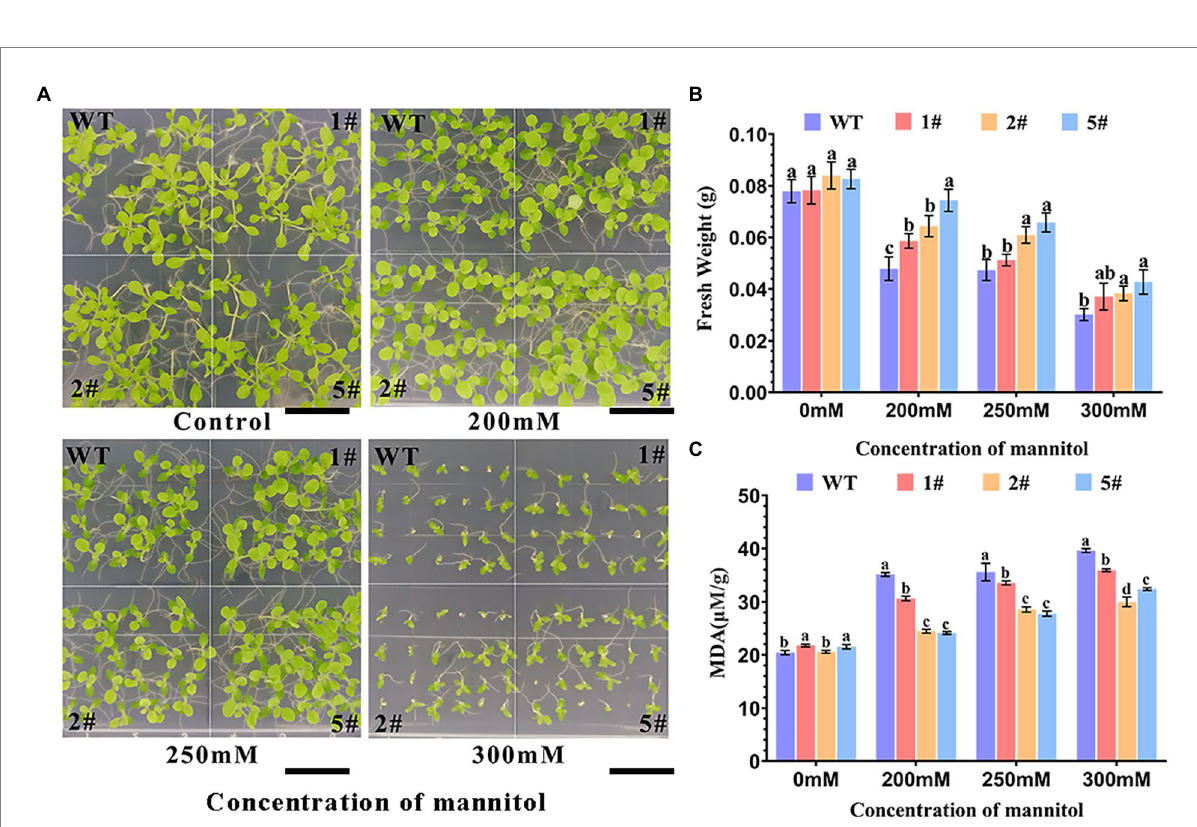
FIGURE 5 Plant root growth of an AfNAC1- overexpression strain and wild-type plants under different concentrations of mannitol stress treatment. WT: wild- type plants; #1, #2, and #5 are three different strains of overexpression plants. (A) Plant root elongation phenotype. (B) Plant root measurement data. (C) Malondialdehyde content measurement data. Error lines indicate the standard errors of three biological replicates with significant differences at the p < 0.05 level. Bar, 7.5